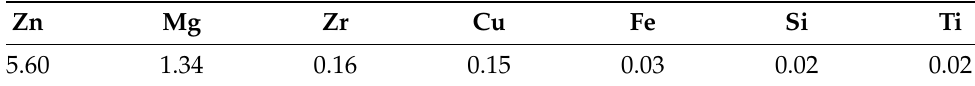
Table 1. Alloy composition of the aluminum alloy [wt%].